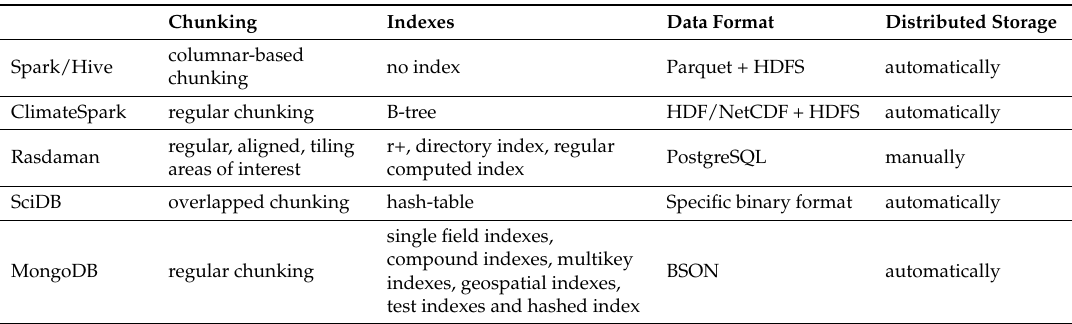
Table 4. The physical data model comparison between Spark, ClimateSpark, Hive, Rasdaman, SciDB, and